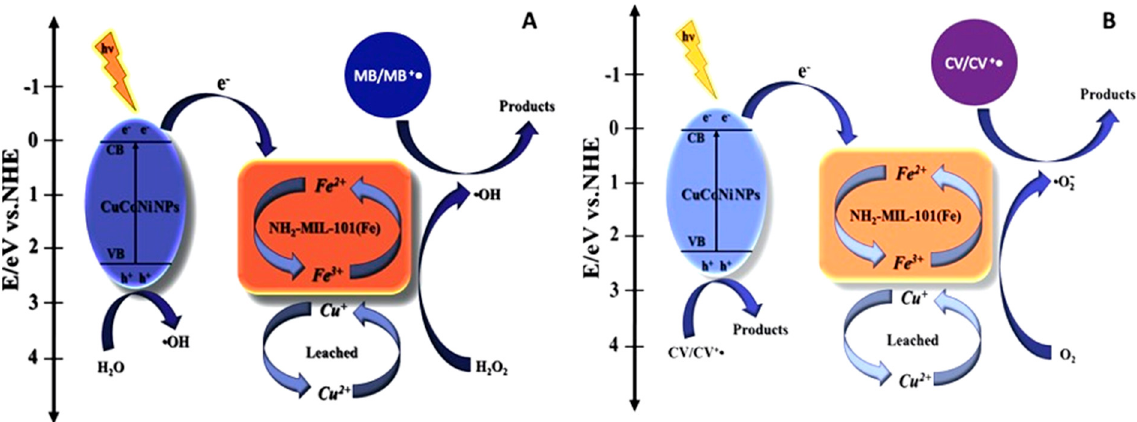
Figure 4. Scheme showing the photodegradation mechanism of: ( A ) methyl blue; ( B ) crystal violet by NH 2 -MIL-101(Fe)@CuCoNi (Reprinted with permission [81]. Copyright 2020 Elsevier).